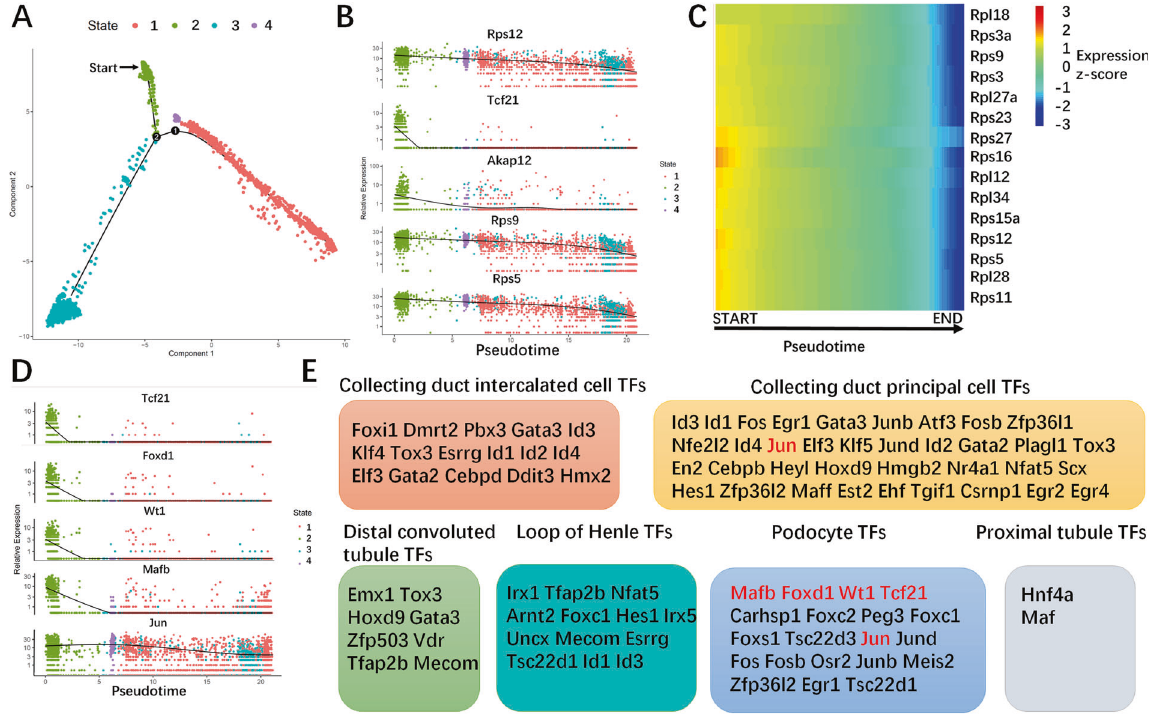
Fig. 4 Features of dynamically changing genes over temporal trajectories. A Cell state transition according to the pseudotime path. There are four major states over pseudotime. B Expression patterns of the top fi ve DEGs over pseudotime. C Heatmap of ribosomal protein genes in the top 50 DEGs of the pseudotime path are signi fi cantly changed in the pseudotime path. All of these genes were highly expressed at the earlier stage and decreased during time. D Top fi ve TFs in the top 200 DEGs over the pseudotime are listed and the expression patterns of these TFs over pseudotime were mapped. E TFs enriched in the six major kidney cell types are listed. The genes highlighted in red in each box were top fi ve TFs among the top 200 DEGs over the pseudotime. All of the top fi ve TFs were enriched in podocytes indicating the important role of podocytes during these development stages. DEGs differentially expressed genes, TFs transcriptional